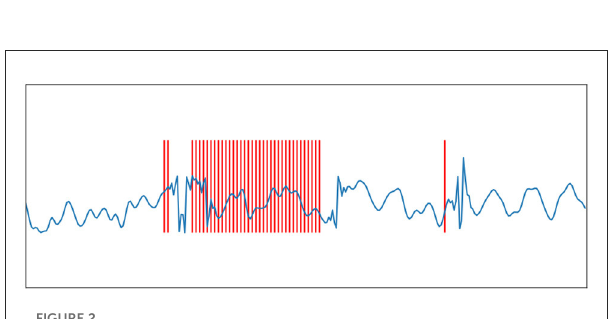
FIGURE2 Ben’s Spiking Algorithm. The blue curve is an EEG signal, and the red vertical line is the spike sequence encoded by the EEG signal according to the BSA encoding algorithm. FIGURE3